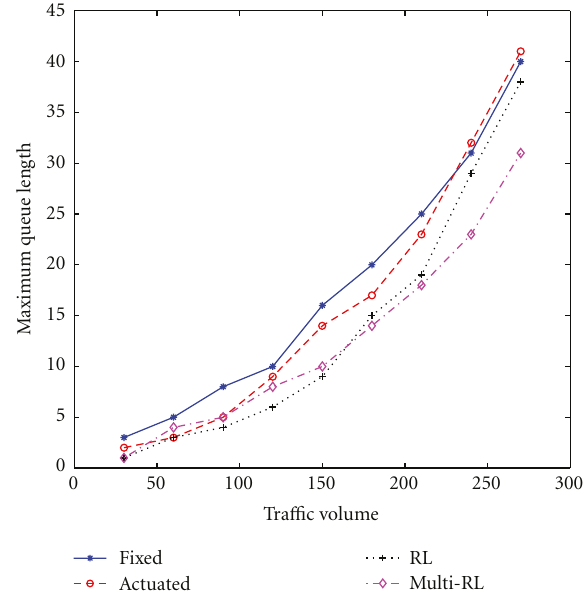
Figure 6: Control e ff ects comparison estimated by maximum queue